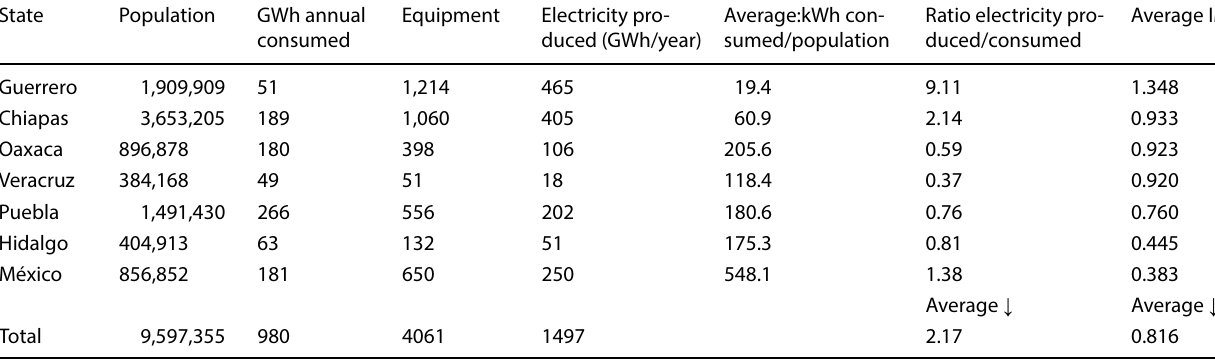
Table 12 Results summary for chosen States, with Marginalisation Index (IM) greater than zero